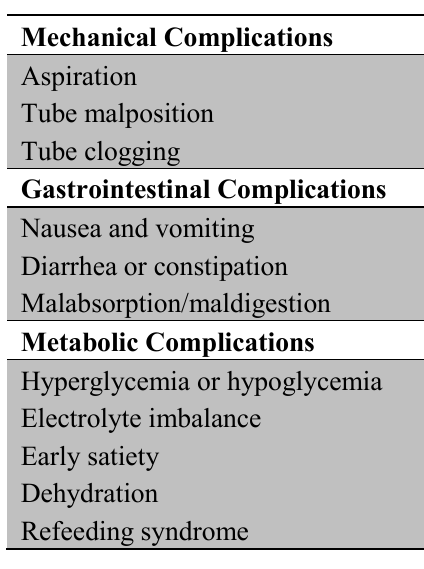
Table 4. Complications associated with enteral